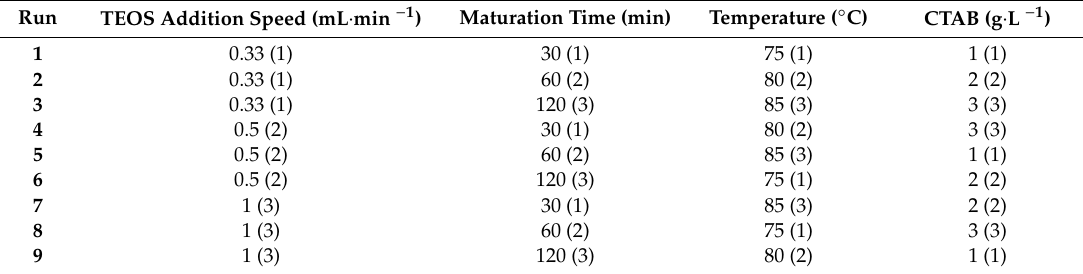
Table 1. Experiments carried out according to Taguchi optimization method. Characters